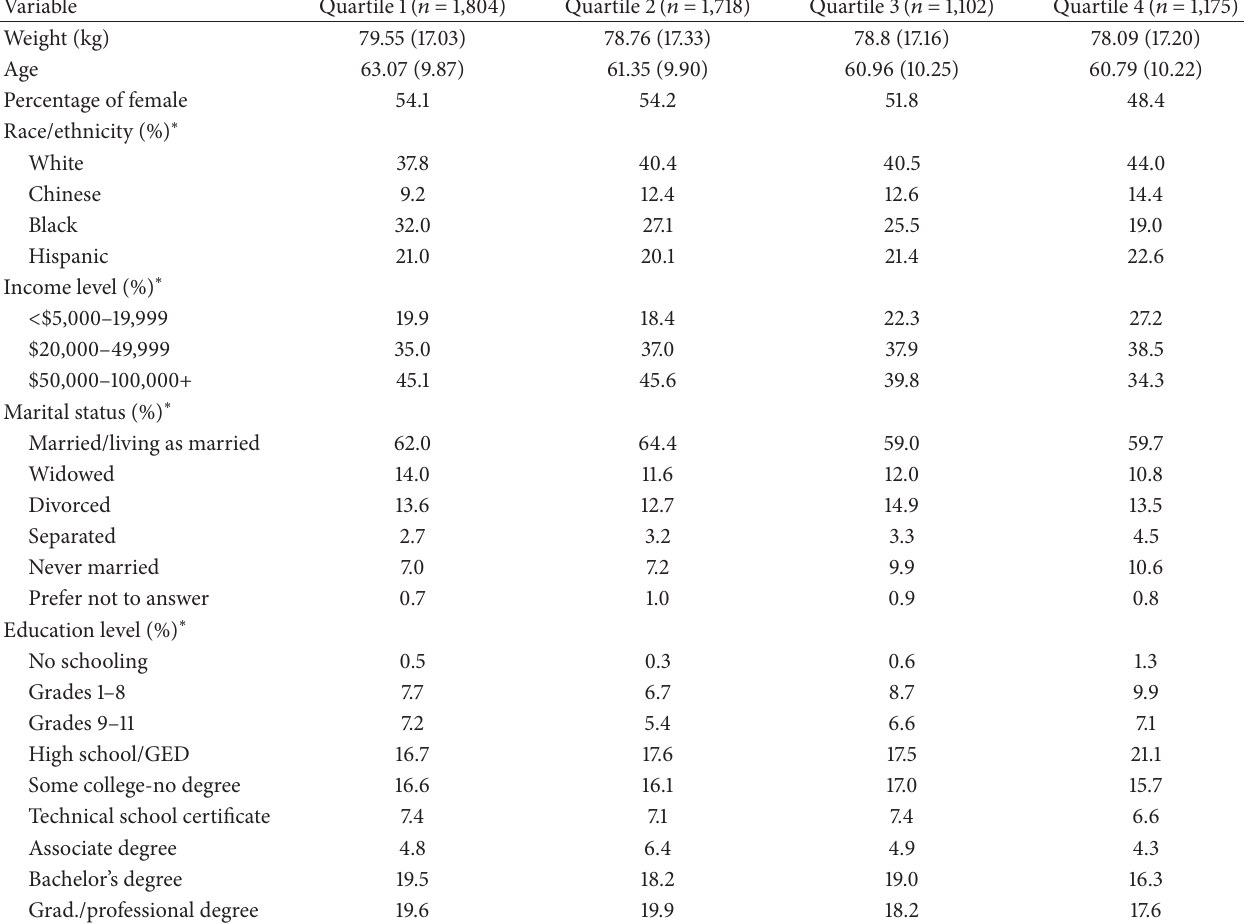
Table 2: Baseline characteristics by sex-specific Spielberger State-Trait Personality Inventory quartiles.